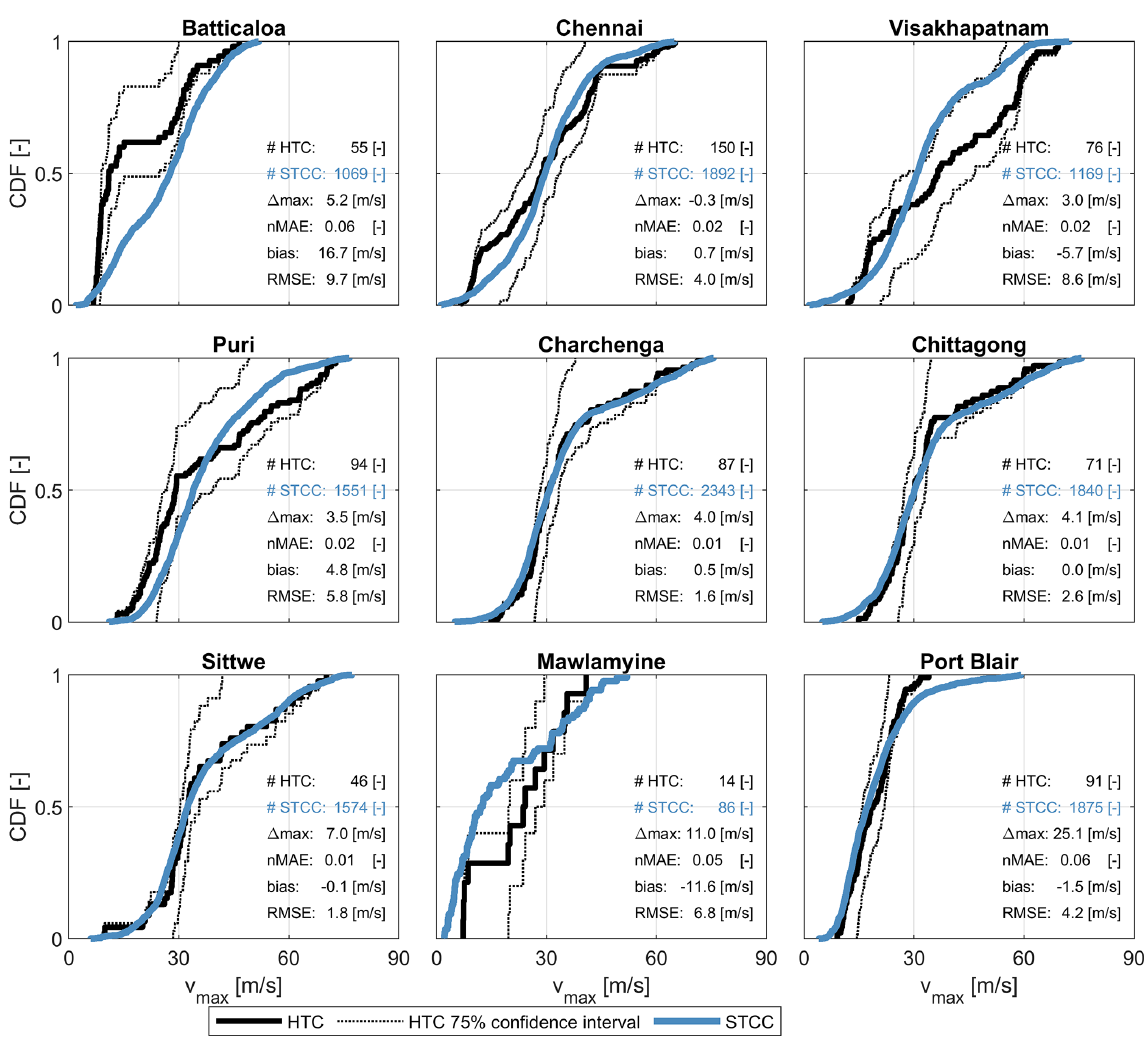
Figure 5. Comparison between CDFs of maximum wind speed ( v max ) for HTCs (black line) with 75% confidence intervals (dashed line) and STCC (blue line) at nine locations along the Bay of Bengal. The functions are estimated based on TCs within a 200km radius of each location. The number of samples (time steps of a TC) within the 200km radius is indicated (#HTC and #STCC), alongside several statistical parameters comparing the HTCs and STCC distributions (i.e., absolute difference in maxima ( (cid:49) max), normalized mean absolute error (nMAE), the relative bias of the median value (bias) and the root-mean-square error (RMSE) of the whole CDF. The nine locations are shown in Fig.